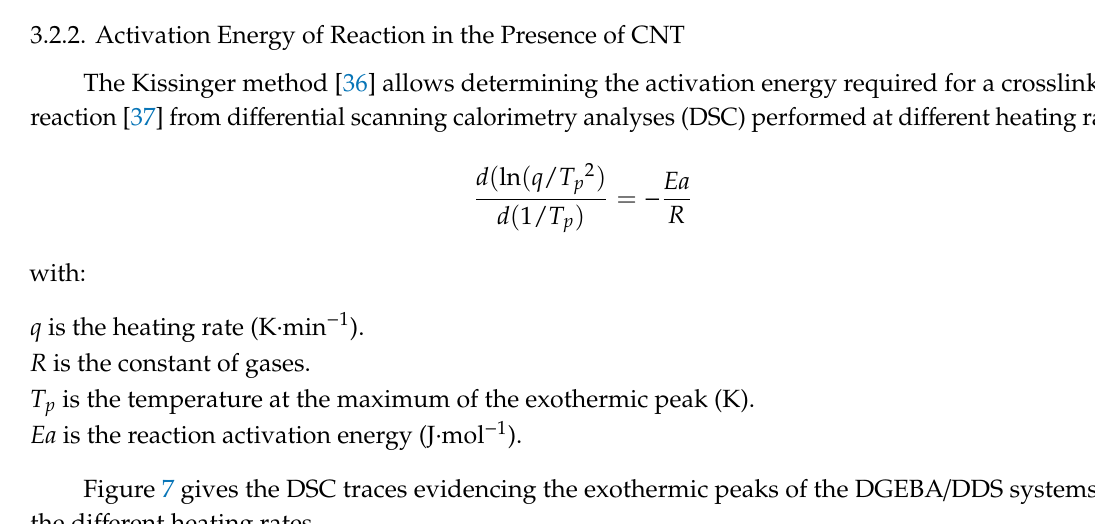
Table 2. Polymerization activation energies of the DGEBA/DDS reactive systems filled with MWNT (0.7% by weight) for different dispersion degrees